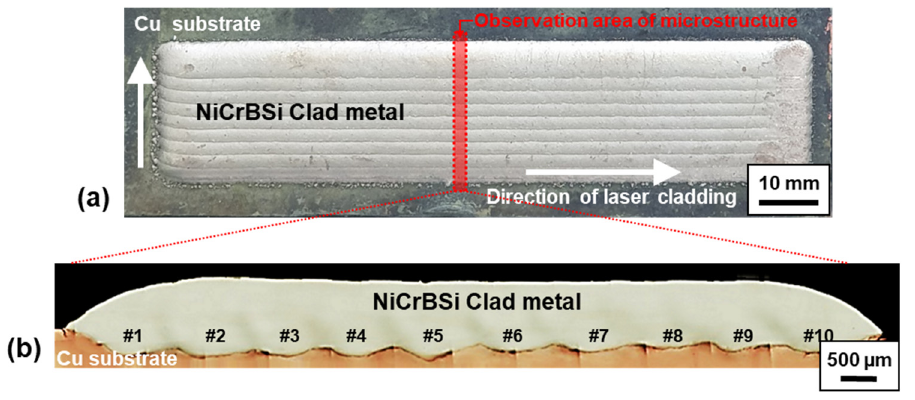
Figure 2. OM images: ( a ) top-view and ( b ) cross-sectional macrostructure of dissimilar laser clads.